Question: Which kind of chart has been used to present this data?
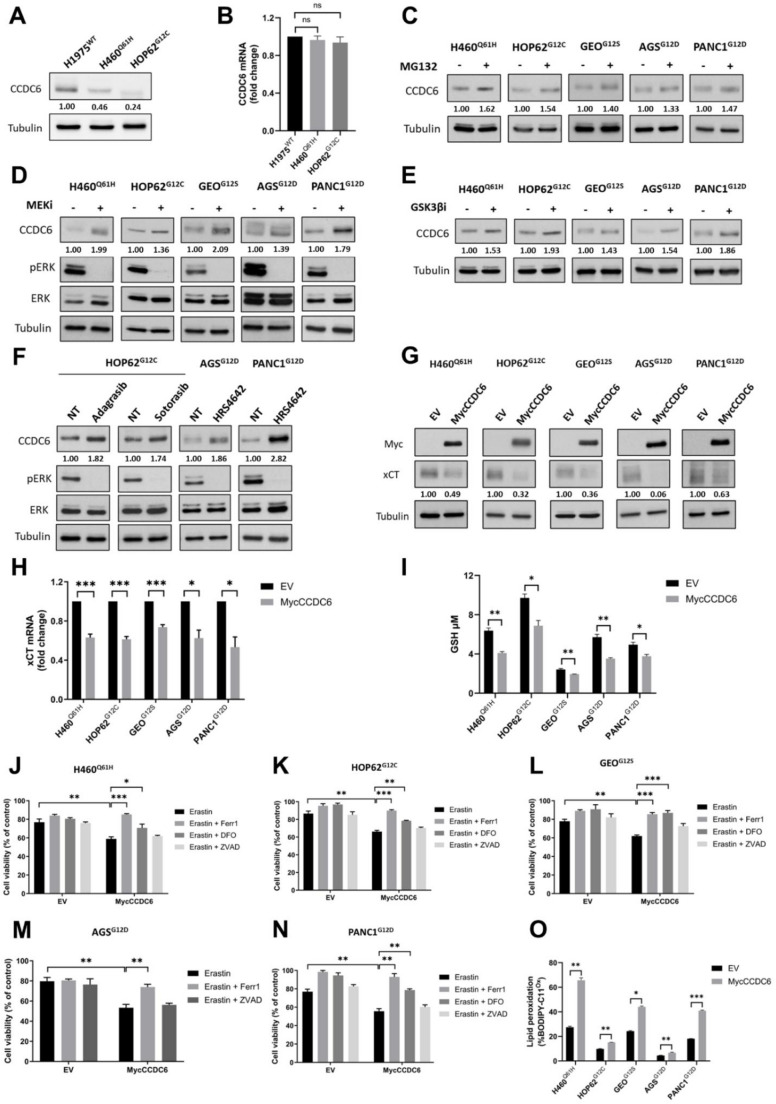
Answer: bar